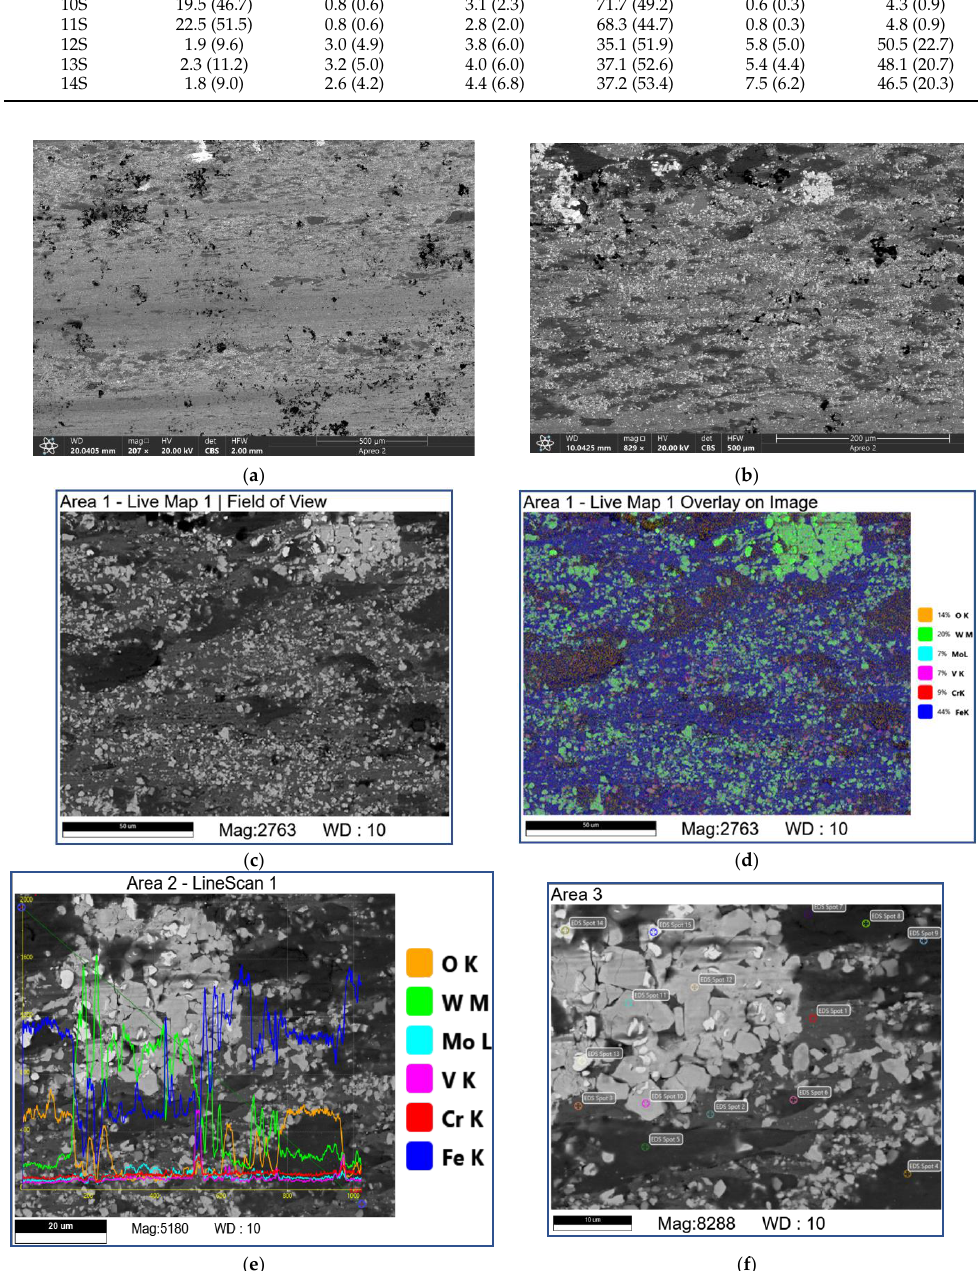
Figure 11. The SEM BSE images ( a – c , e , f ), overlay EDS image ( d ) and EDS line scans ( e ) of M2/W coating worn surface. Data presented for specimens after sliding speed of 2.4 m/s. Numbers on ( f ) indicate probe zones for which EDS elemental concentrations were determined indicated in Table 4.